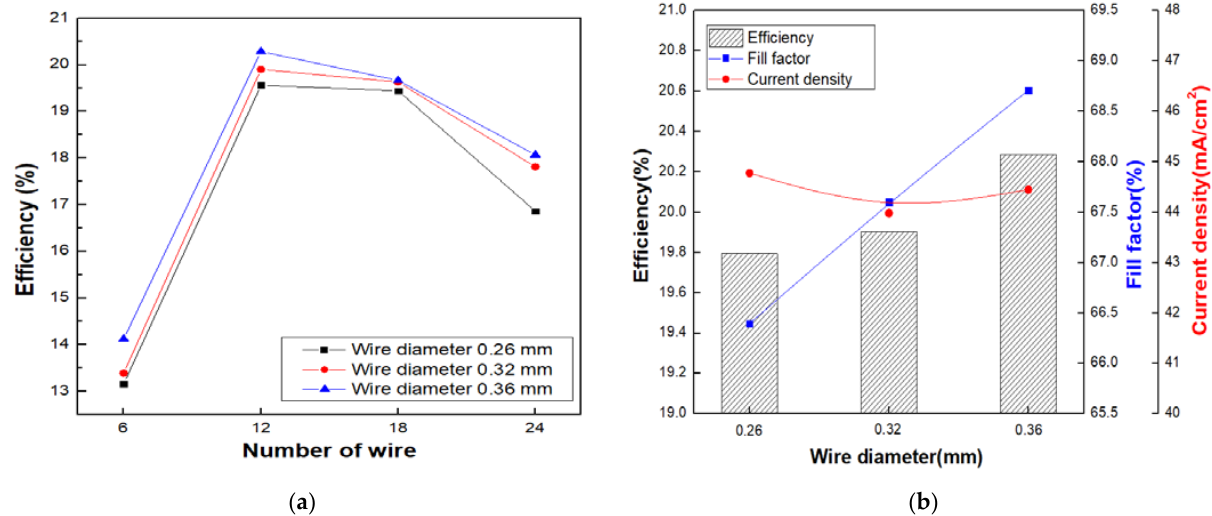
Figure 8. Characteristics of a 1 × 1 unit module based on the number of wires ( a ) and the wire diameter ( b ).